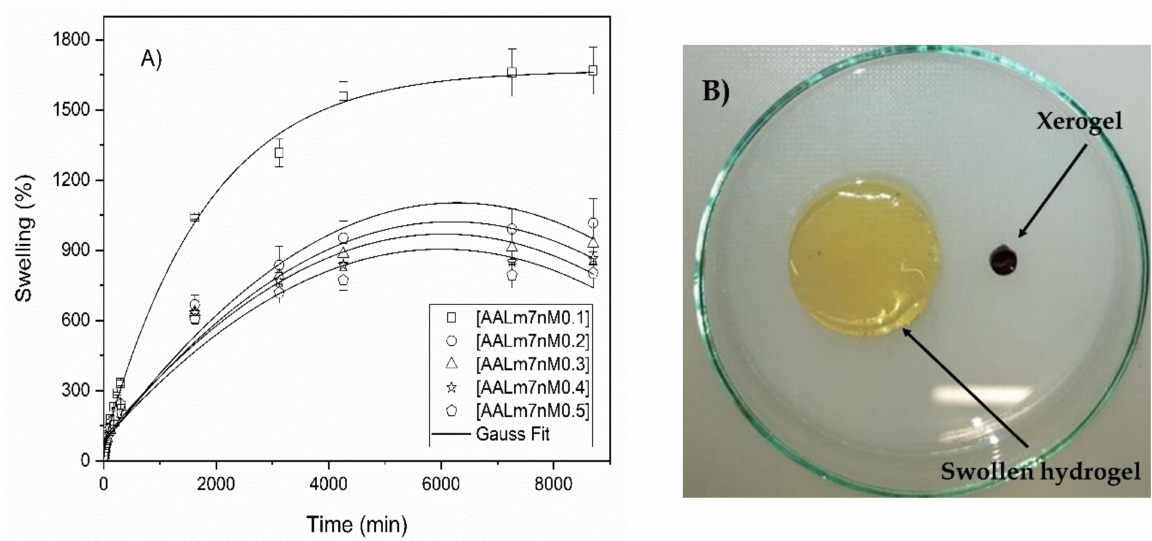
Figure 8. Swelling in water of hydrogels with AA, functionalized AKL and NMBA. ( A ) Swelling behavior of hydrogels, ( B ) comparative capture of xerogel and swollen